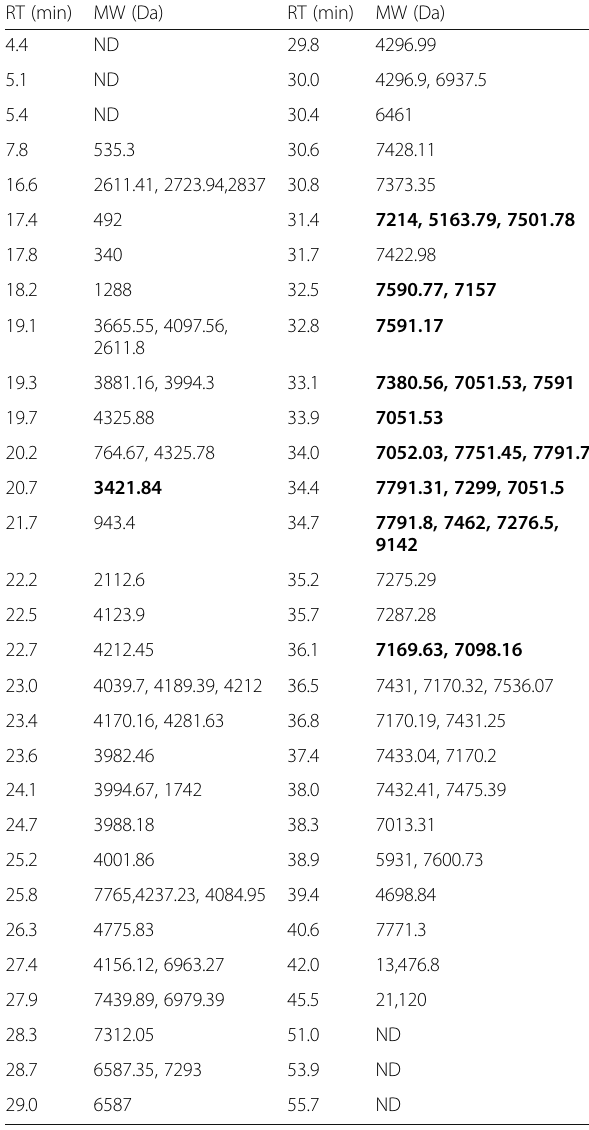
Table 1 Determination of molecular weights (MW) by mass spectrometry of the venom components from C. hirsutipalpus RT (min) MW